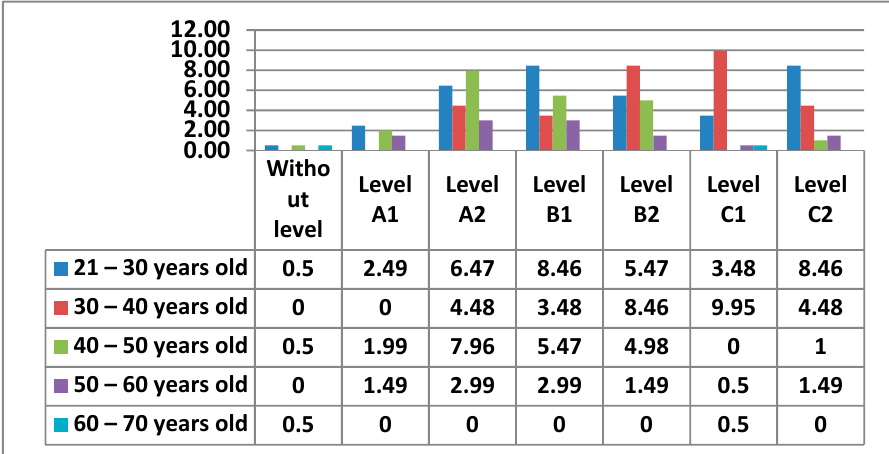
Figure 10. Percentage of teachers by level of digital competence in Area 1.